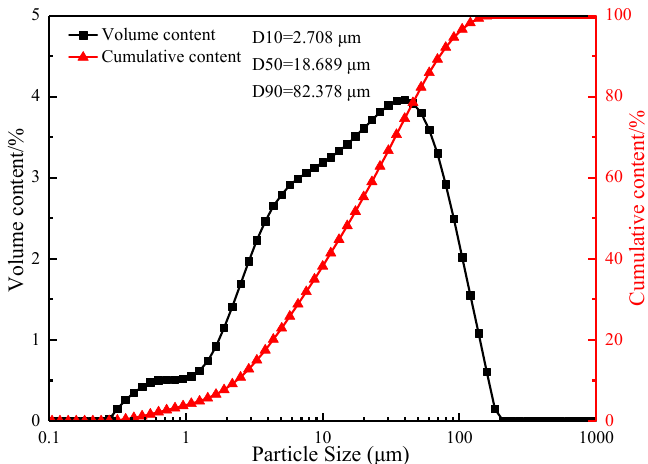
Figure 2. The laser diffraction particle size analysis of the vanadium titanomagnetite. Table 2. Proximate analysis of humic substance-based binder and the chemical composition of the binder ash/wt%.